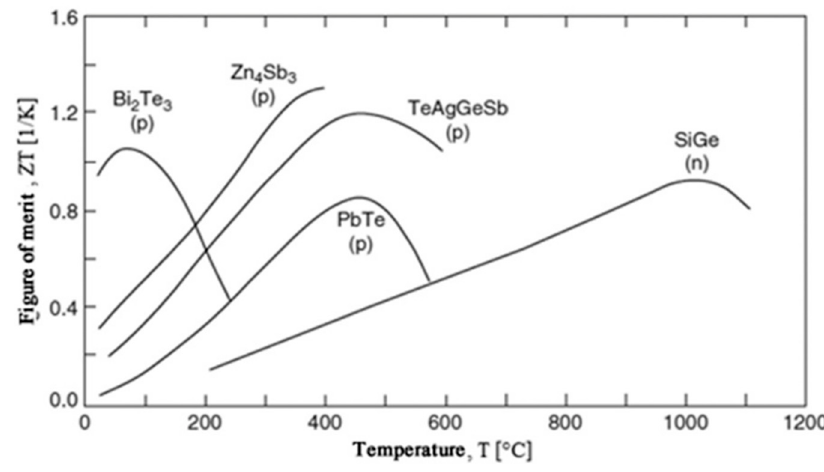
Figure 1. ZTs of common TE materials for p - and n -types. Reprinted with permission from [41].